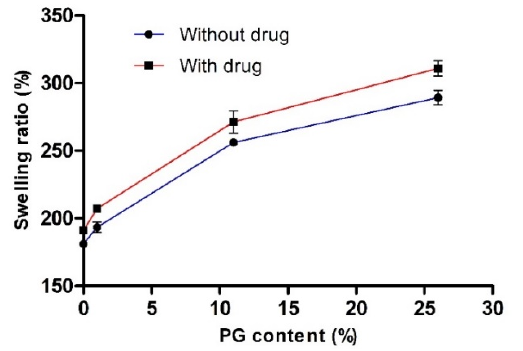
Figure 3. Effect of propylene glycol (PG) on the swelling ratio (%). Data are expressed as the mean ± standard deviation ( n = 4).